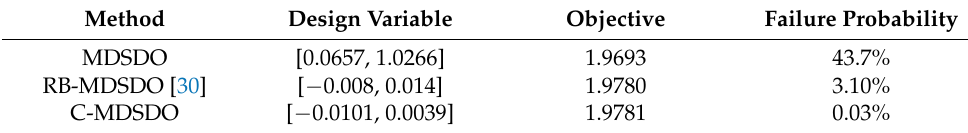
Table 2. The optimization result comparison between MDSDO and